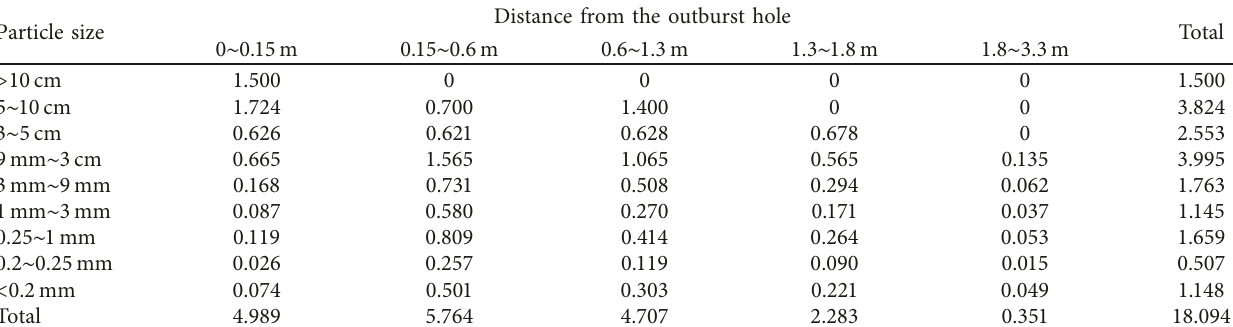
Table 2: Coal dust distribution statistics of roadway after outburst